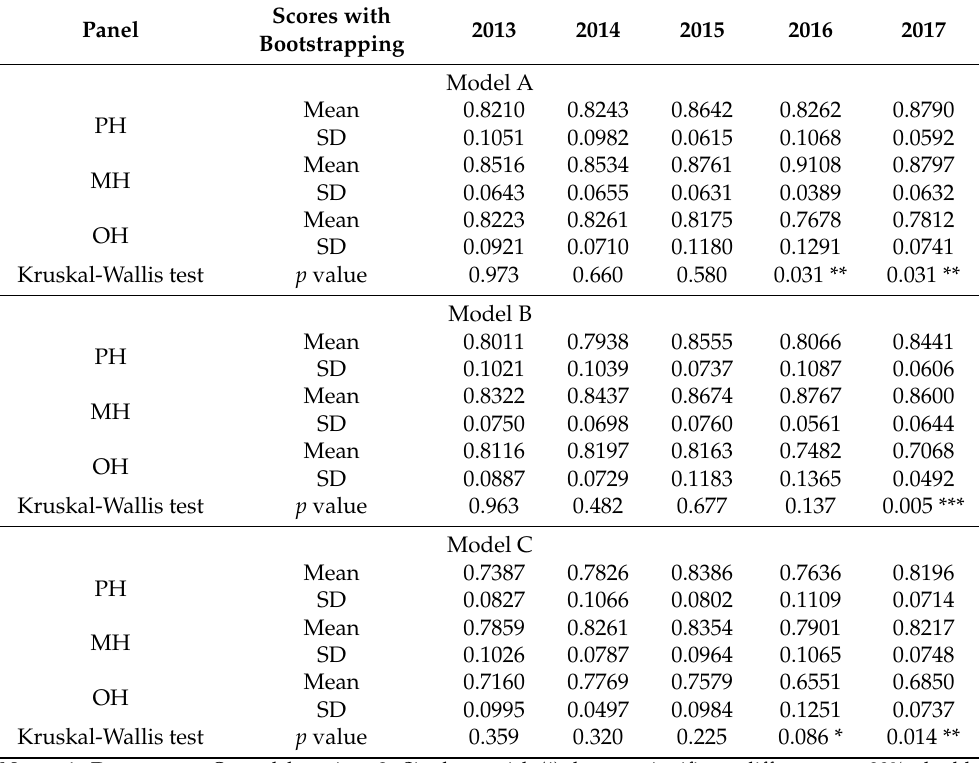
Table 5. Scores with Bootstrapping for DEA CRS (CCR model) orientated to